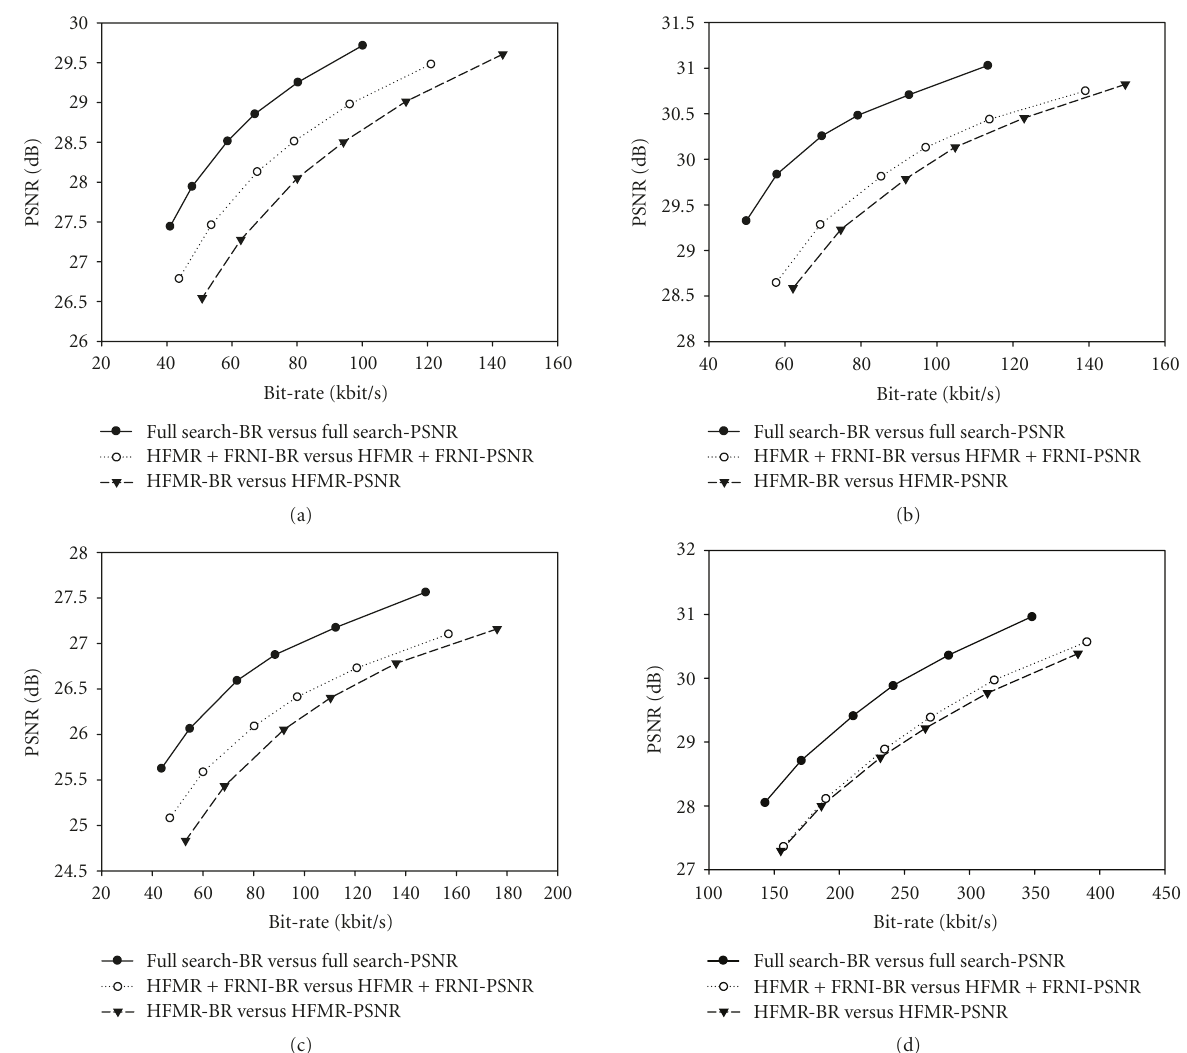
Figure 17: The R-D curves for our proposed FRNI. (a) Foreman. (b) TableTennis. (c) Coastguard. (d)